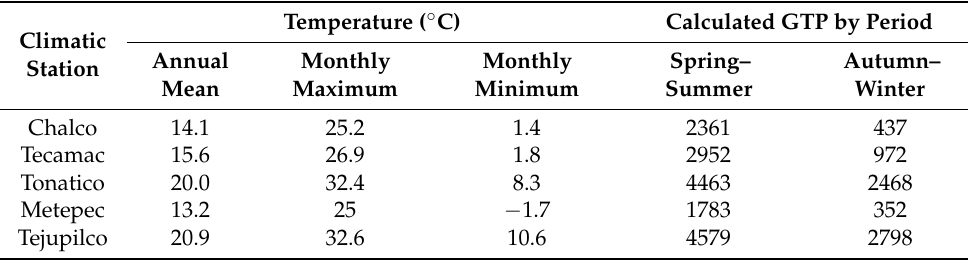
Table 1. GTP per cycle (Spring–Summer (S–S) and Autumn–Winter (A–W)) estimated in five pro- ductive regions of the state of Mexico using annual average temperature.